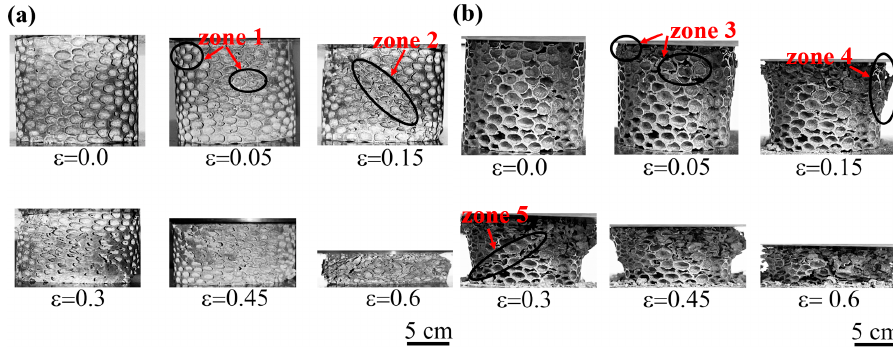
Figure 7. Evolution of deformation of SSFs during compression ( a ) 304; ( b ) 430.